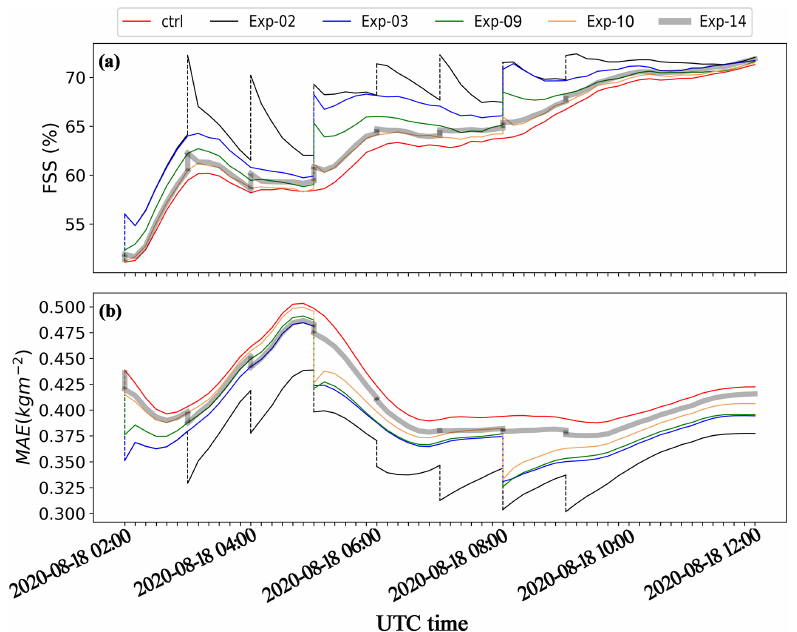
Figure 14. Time evolution of (a) FSS and (b) MAE of the ensemble mean of the first-guess forecast and analysis of CWP for the cycled DA experiments with varying observation errors and observation pre-processing (with and without